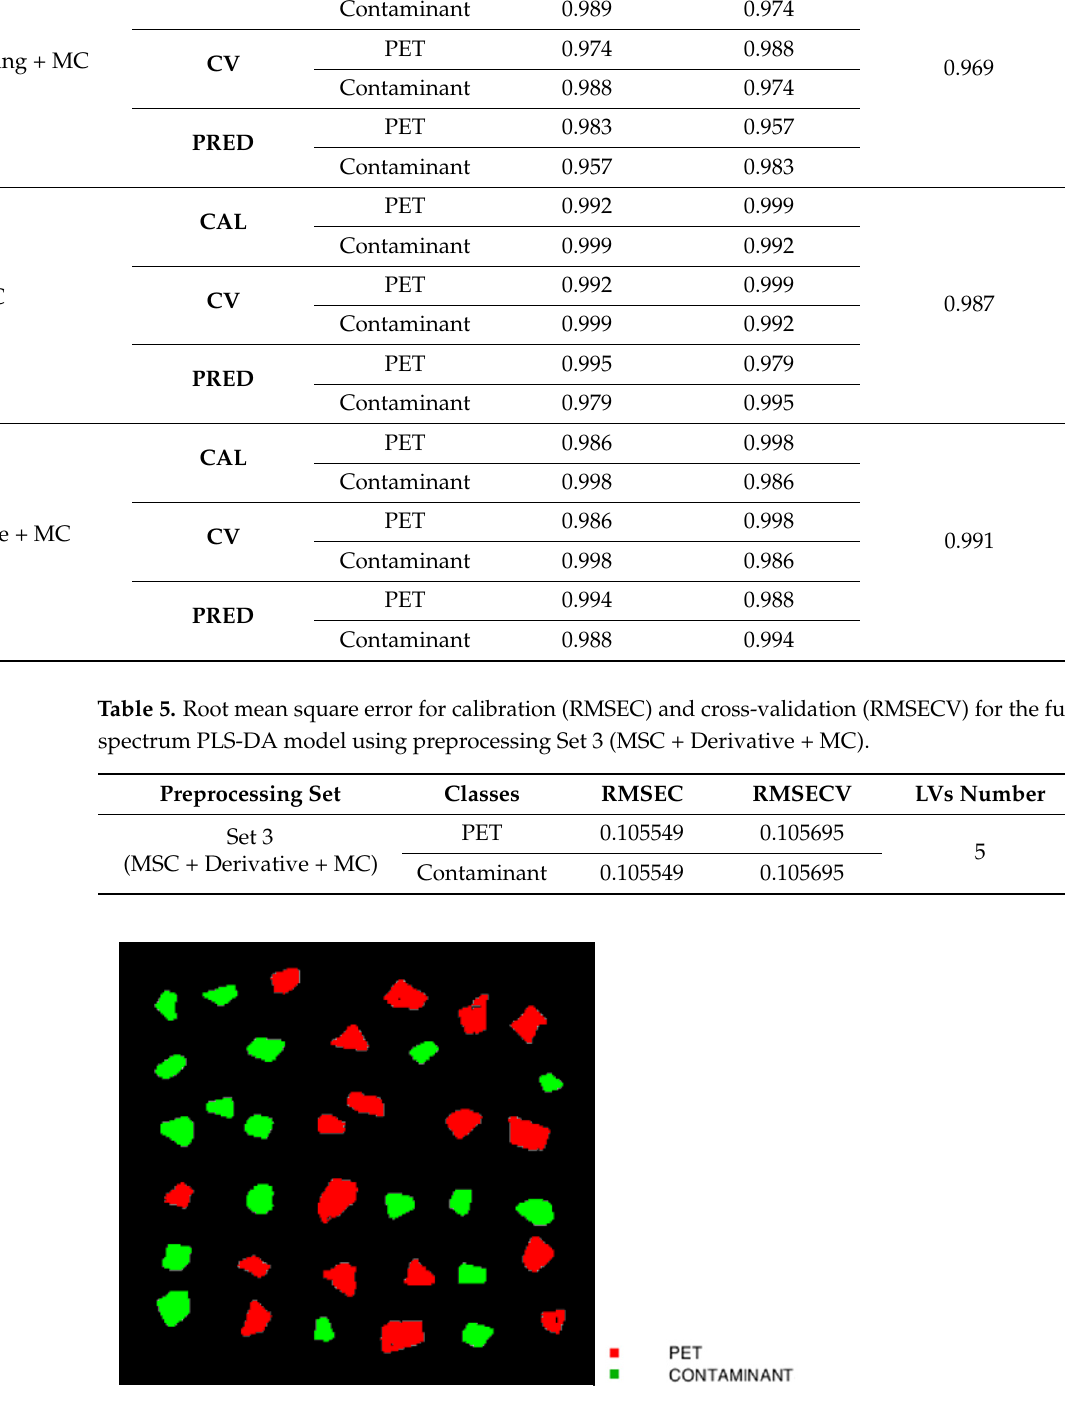
Figure 9. Prediction maps for the full spectrum PLS-DA model of preprocessing Set 3 (MSC + Derivative + MC).